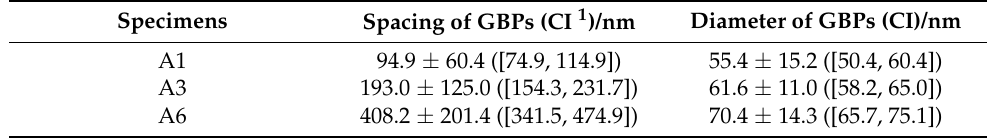
Figure 8. STEM–EDS result of grain boundary precipitates (GBPs). Table 6. Average spacing and diameter of